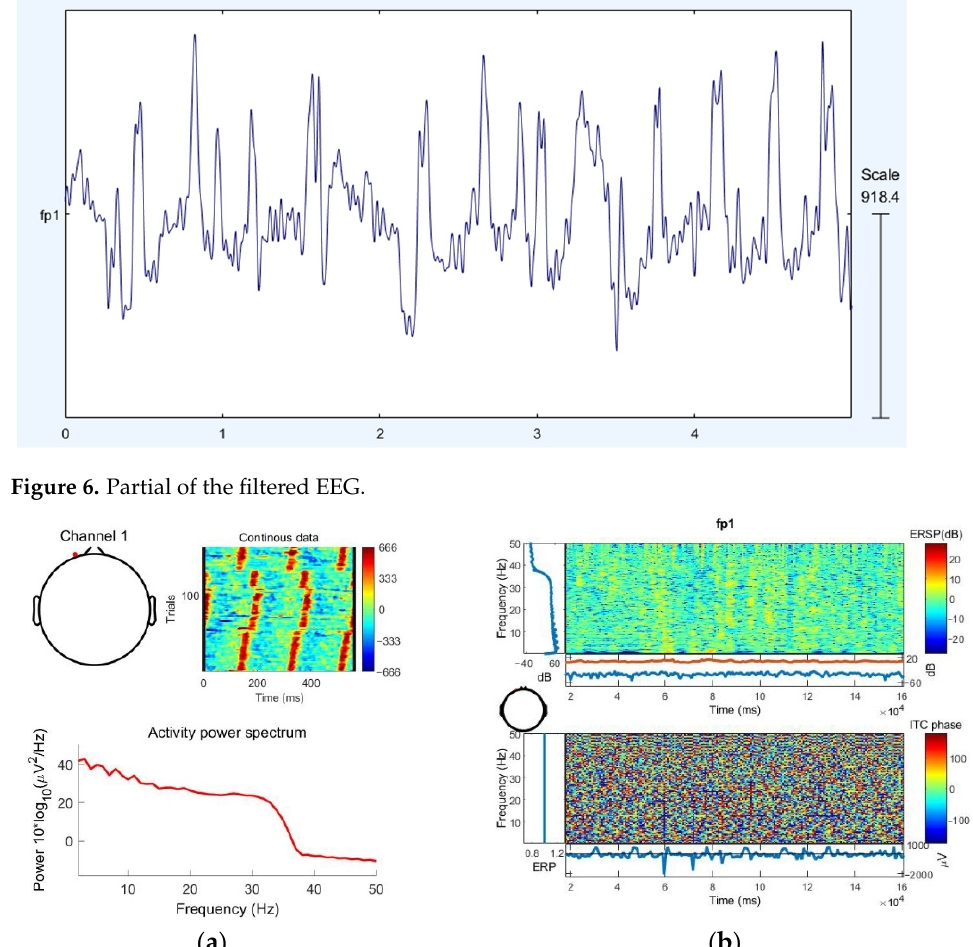
Figure 7. Related EEG feature information ( a ) channel and related power spectrum ( b ) event-related spectral perturbation and inter trial coherence with frequency.